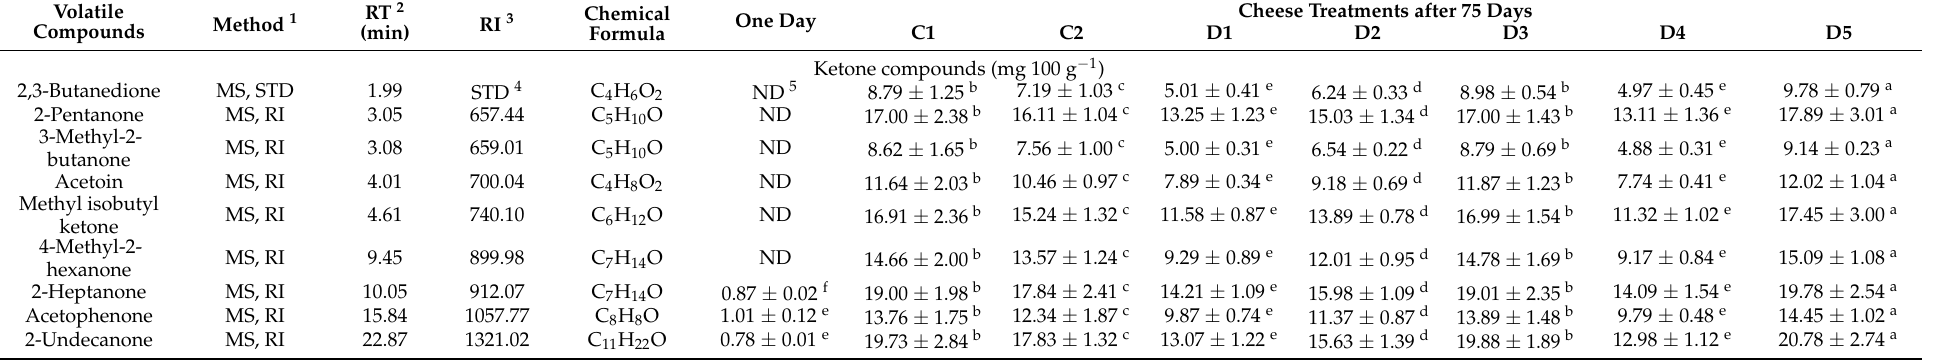
Table 4. Volatile ketone compounds identified in cheese samples packaged under modified atmospheres (means ±